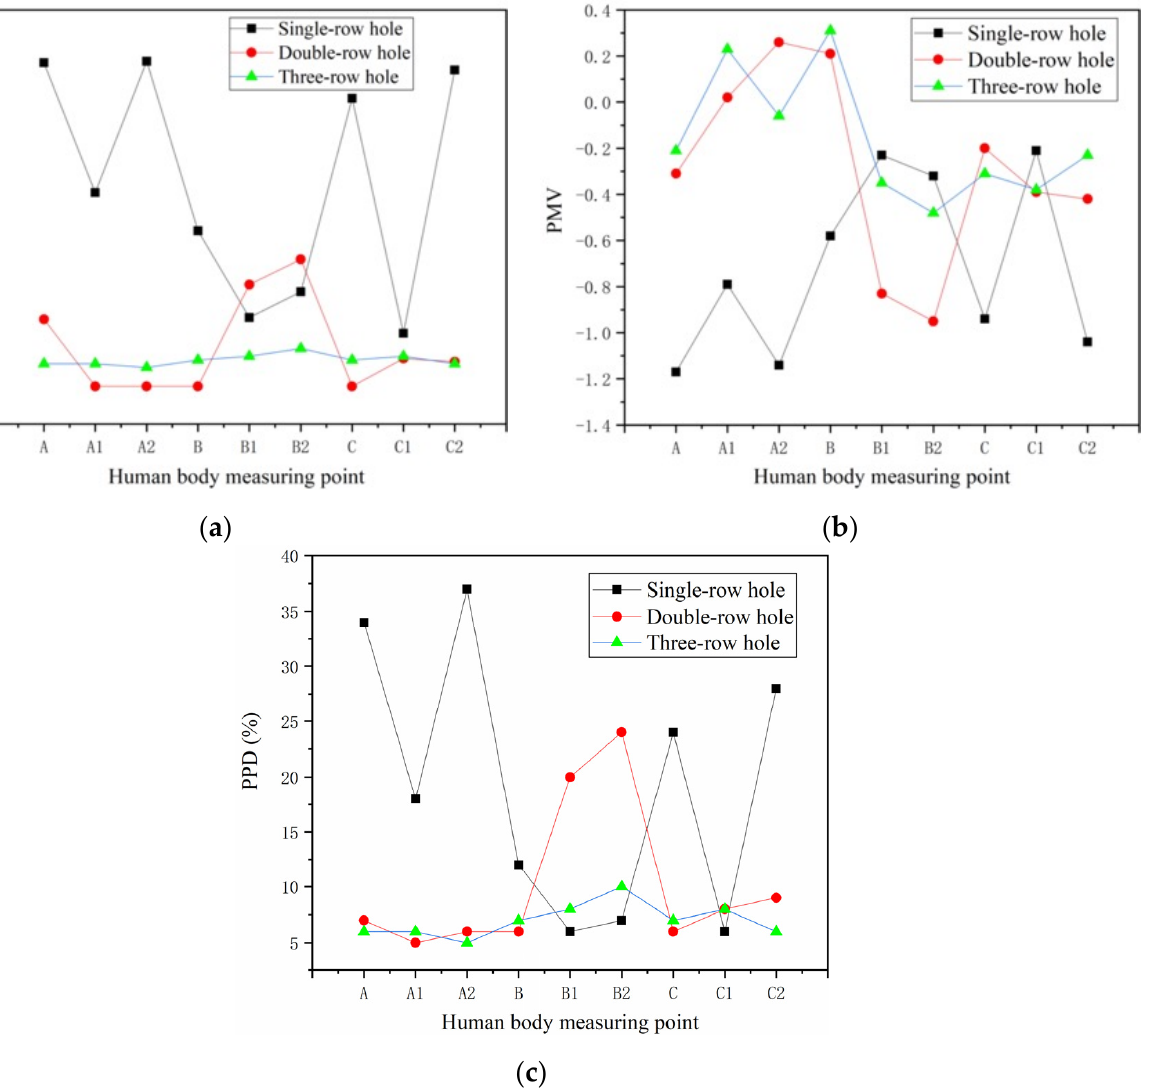
Figure 17. ( a ) The PD in various parts of the body. ( b ) The PMV in various parts of the body. ( c ) The PPD in various parts of the body.